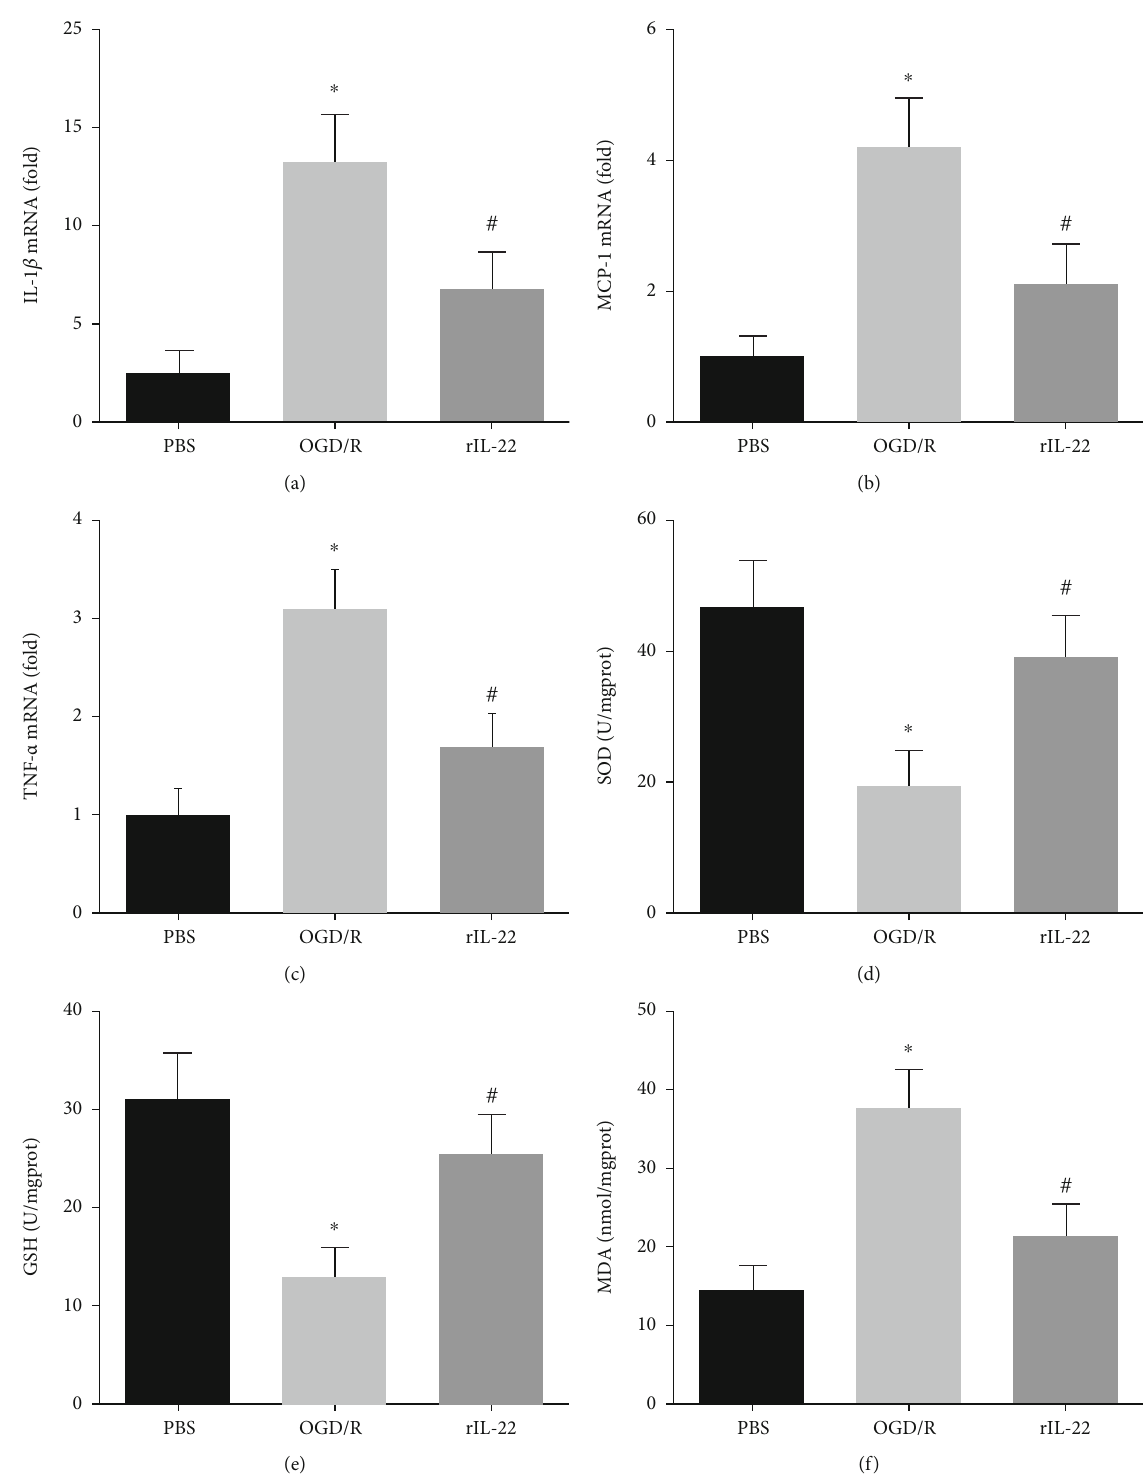
Figure 4: IL-22 treatment inhibited OGD/R-induced in fl ammation and oxidative stress. The mRNA expression of IL-1 β (a), MCP-1 (b), and TNF- α (c) was detected in PC12 cells ( n = 6 ). The levels of SOD (d), GSH (e), and MDA (f) were detected in PC12 cells ( n = 6 ). ∗ P < 0 : 05 vs. PBS group; # P < 0 : 05 vs. OGD/R